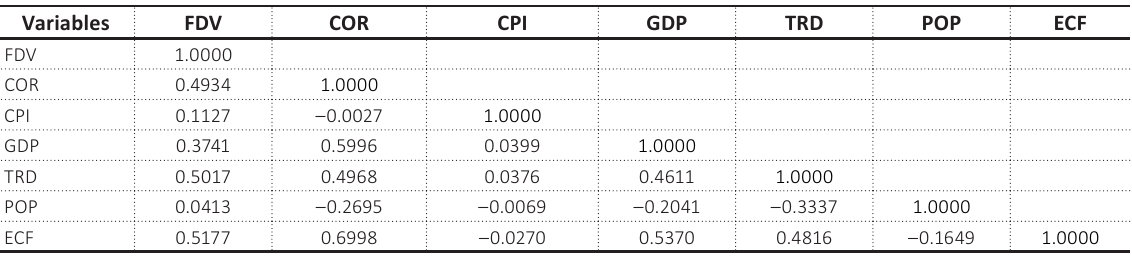
Table 3. Financial development, corruption, and foreign direct investment Explanatory Variables